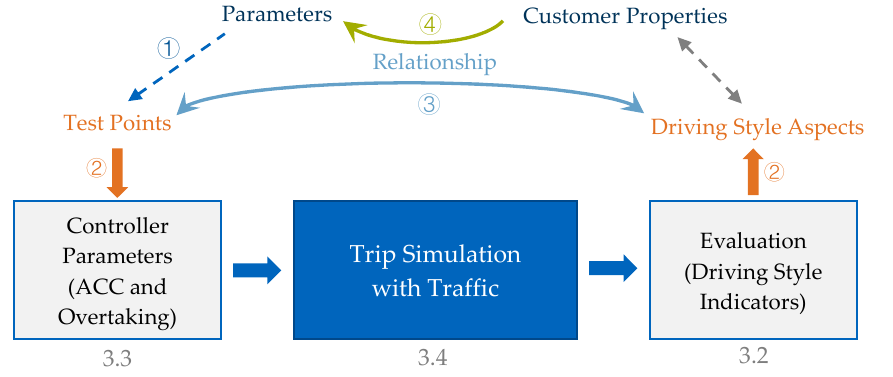
Figure 13. Workflow for parameterizing the driving style.